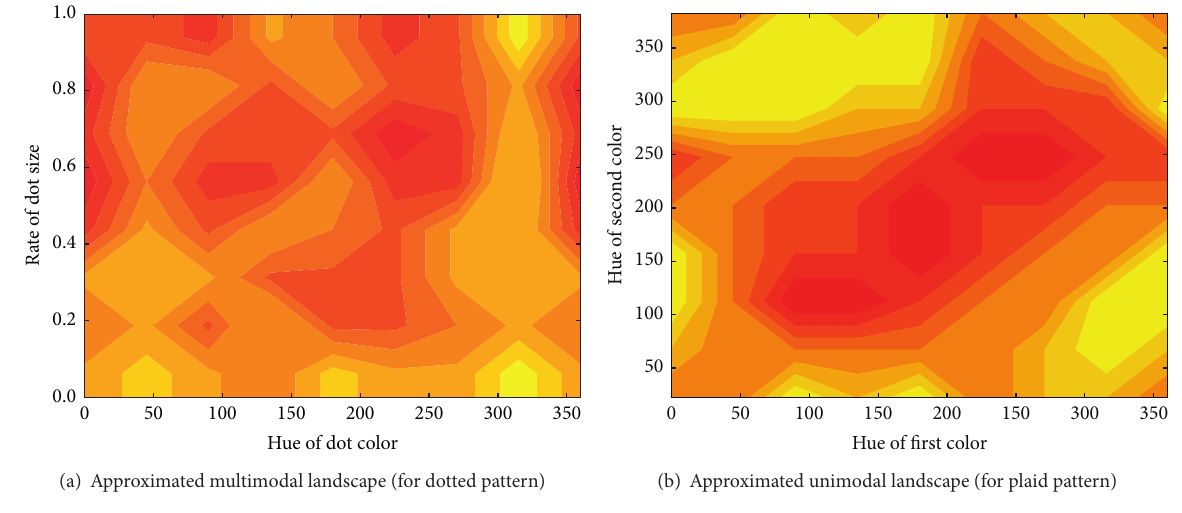
Figure 14: Examples of approximated Kansei landscapes.